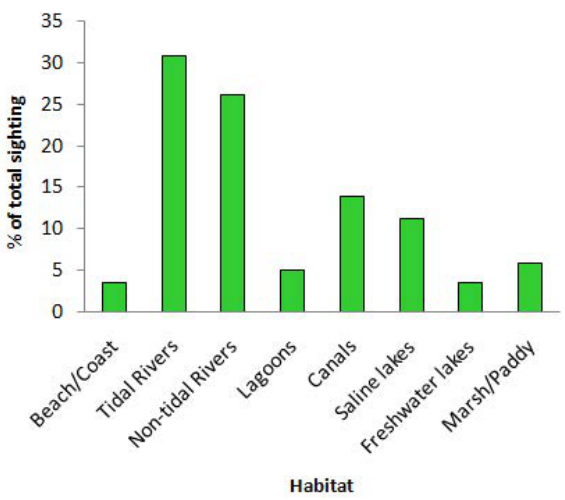
Figure 2. Size structure of Saltwater Crocodiles sighted in crocodile vigilance zones during 2008–2012. The sub- adult category comprises mature and immature females and immature males. Eyes Only were recorded during spotlight